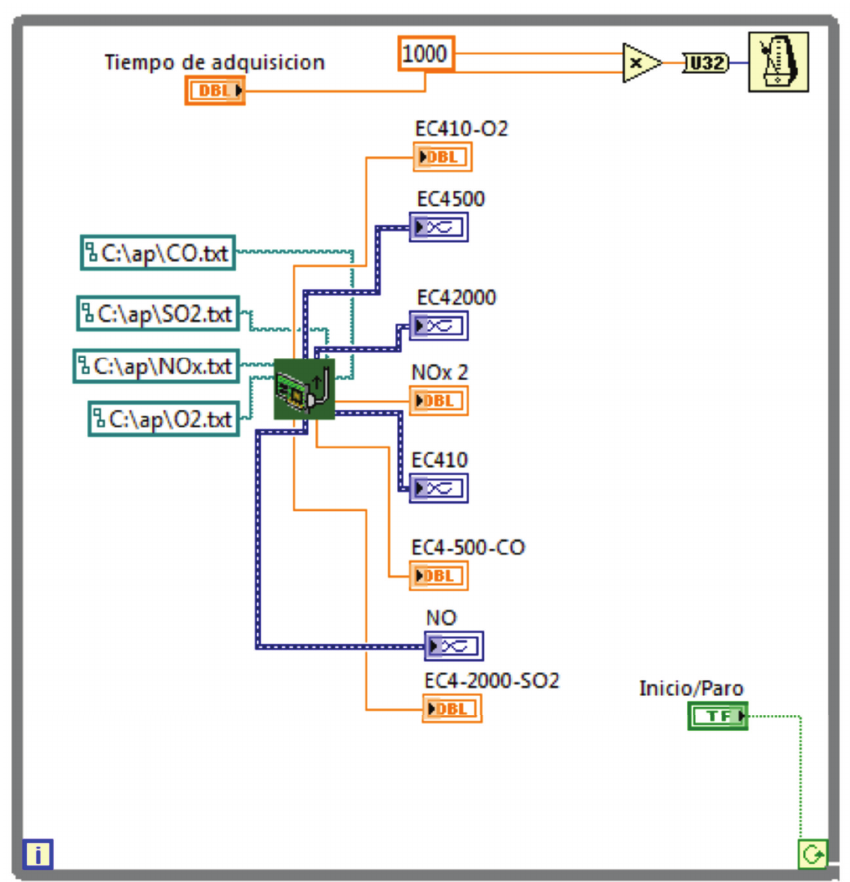
Figure 14: While loop 2 programing